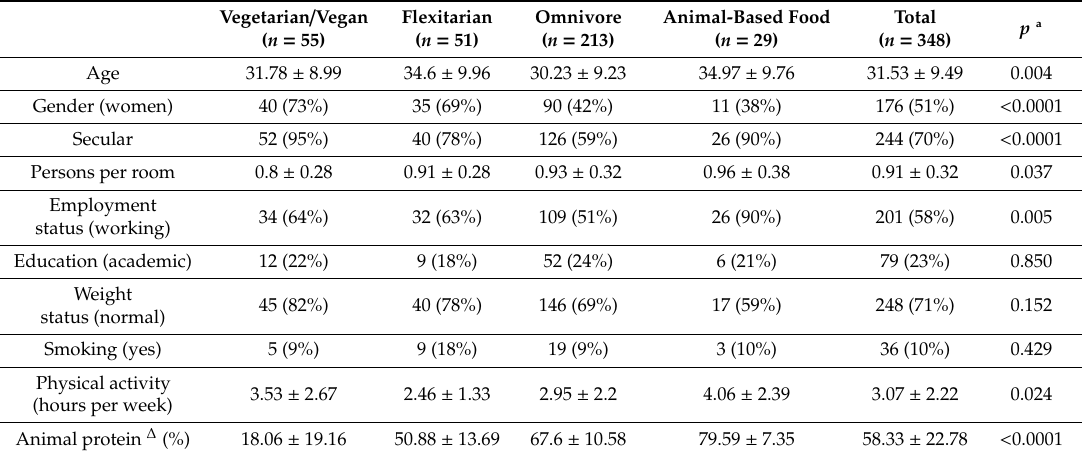
Table 3. Characterization of participants by eating patterns.